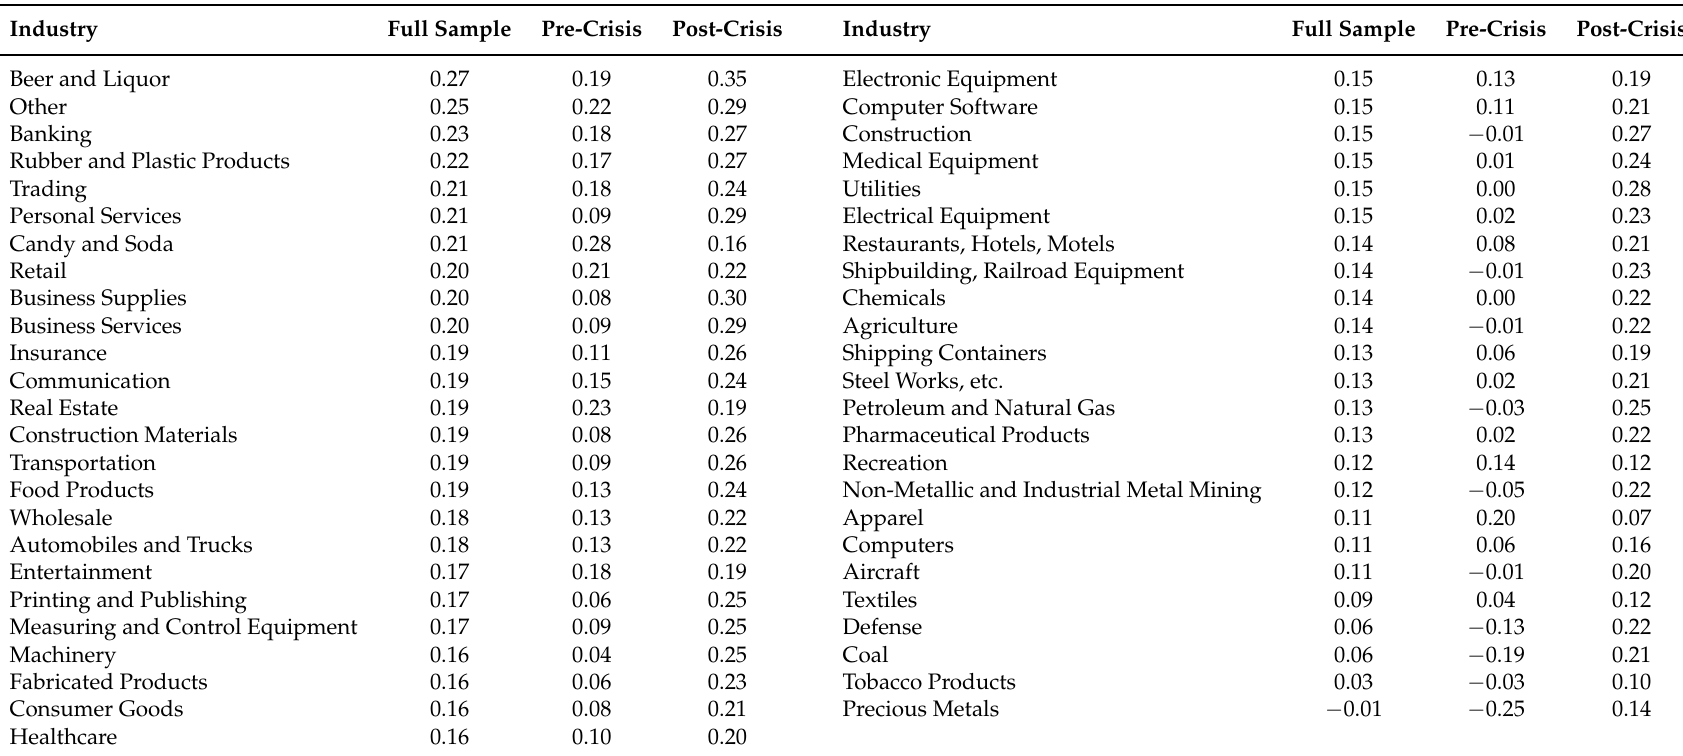
Table 2. The table reports the Pearson correlation between the global art index and each of the Fama and French 49 industry groups over three time periods. Full sample refers to correlations computed using monthly data ranging from 2002:04 to 2017:09; pre-crisis correlations are computed using data ranging from 2002:04